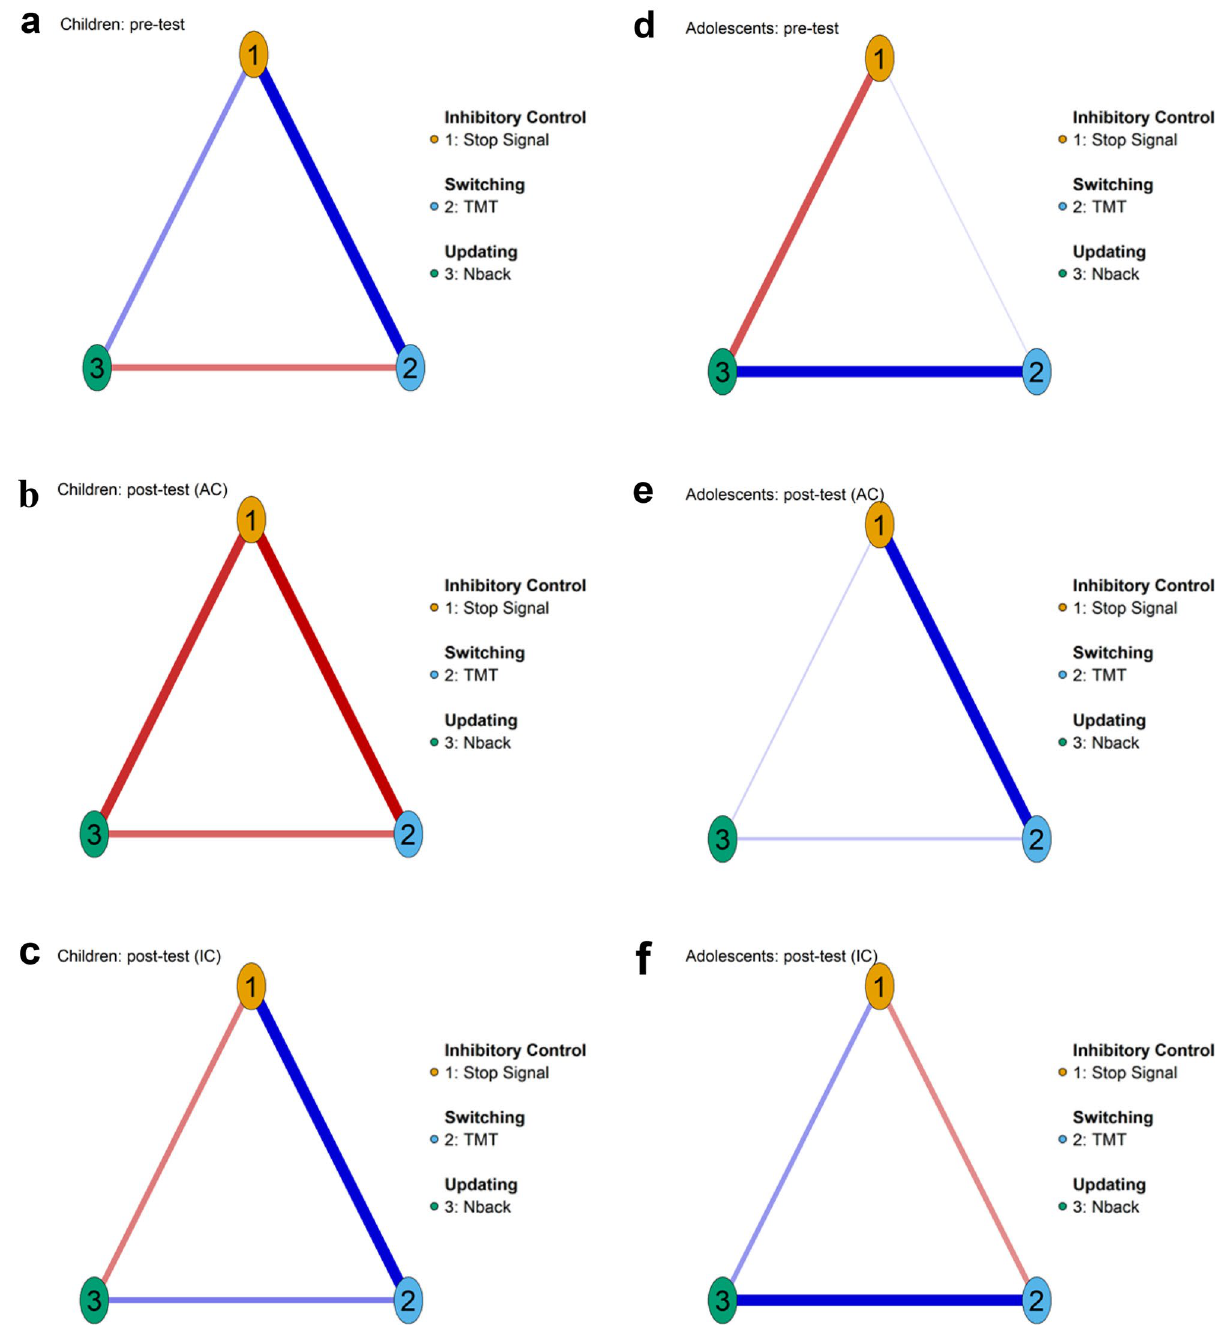
Figure 5. Three-nodes networks for children ( a – c ) and adolescents ( d – f ), before ( a , d ), after active control training (AC; b , e ) and after inhibitory control (IC; c , f ) training. Color of nodes correspond to an executive function. Each number in the networks corresponds to an EF task (see details in the